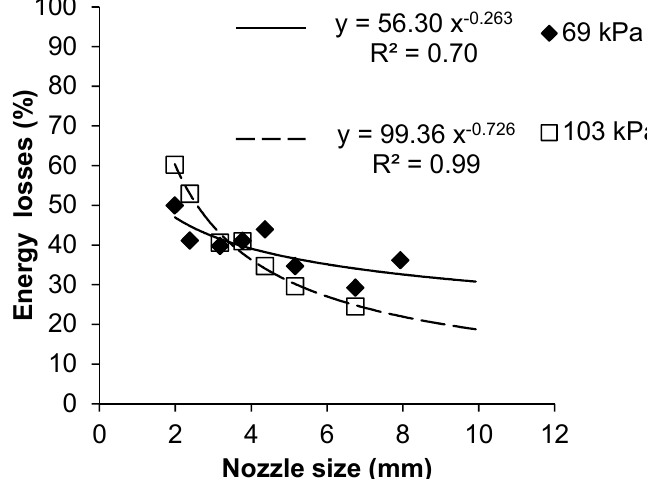
Figure 6. Estimated energy losses as function of the nozzle size. Energy loss regressions are shown for both pressures 103 kPa and 69 kPa with different symbols.